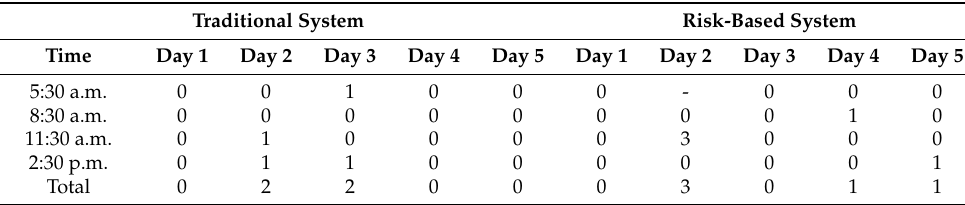
Table 2. Presence of Salmonella enterica distributed per day and time. Traditional